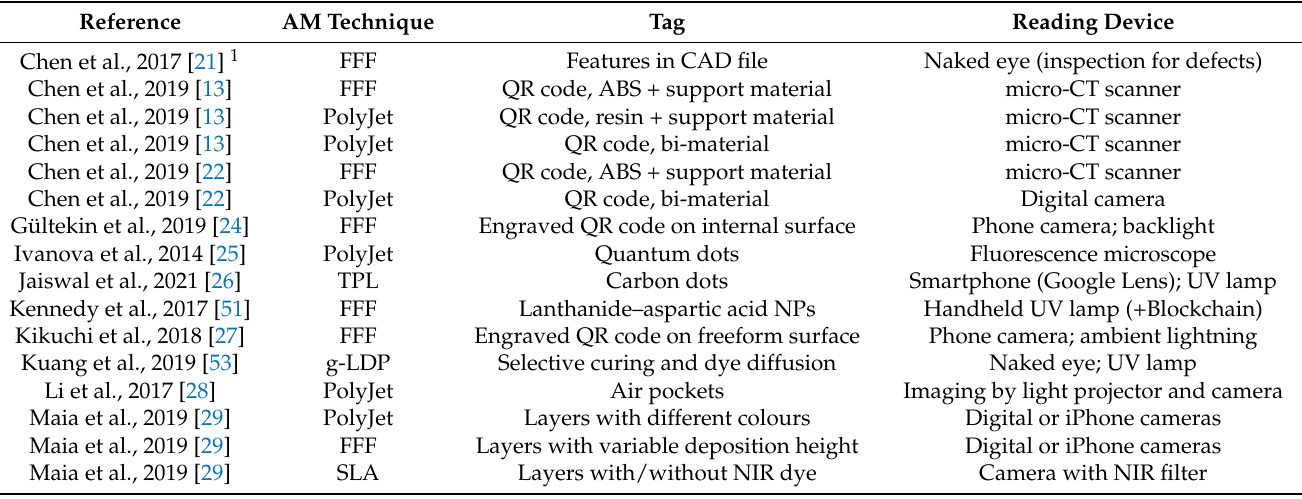
Table 3. Summary of tagging strategies demonstrated in the literature for polymer-based AM parts